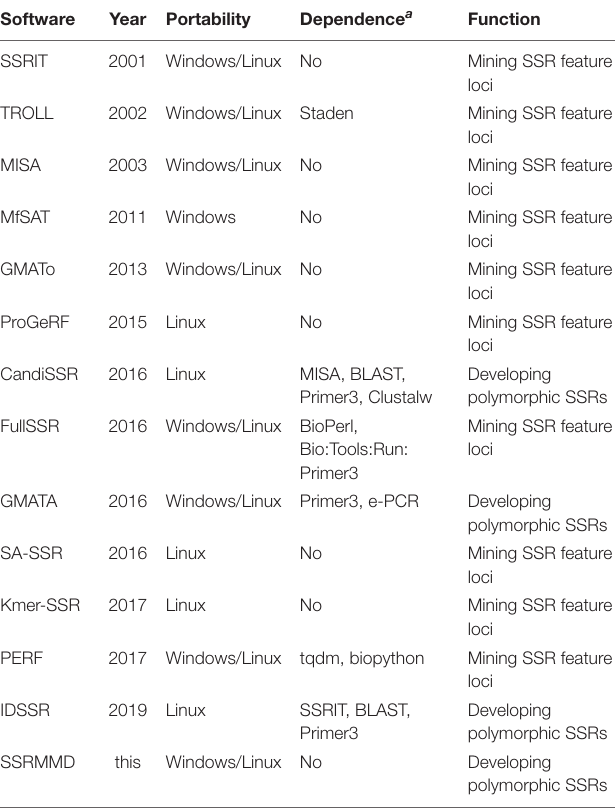
TABLE 1 | Various features of SSRMMD and existing software programs for mining perfect